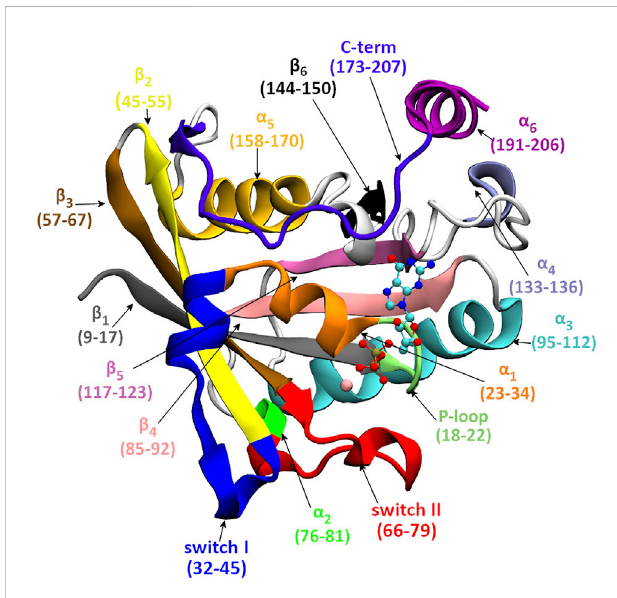
The secondary structure elements of ran. The GDP is shown as CPK, Mg 2+ as vdW.